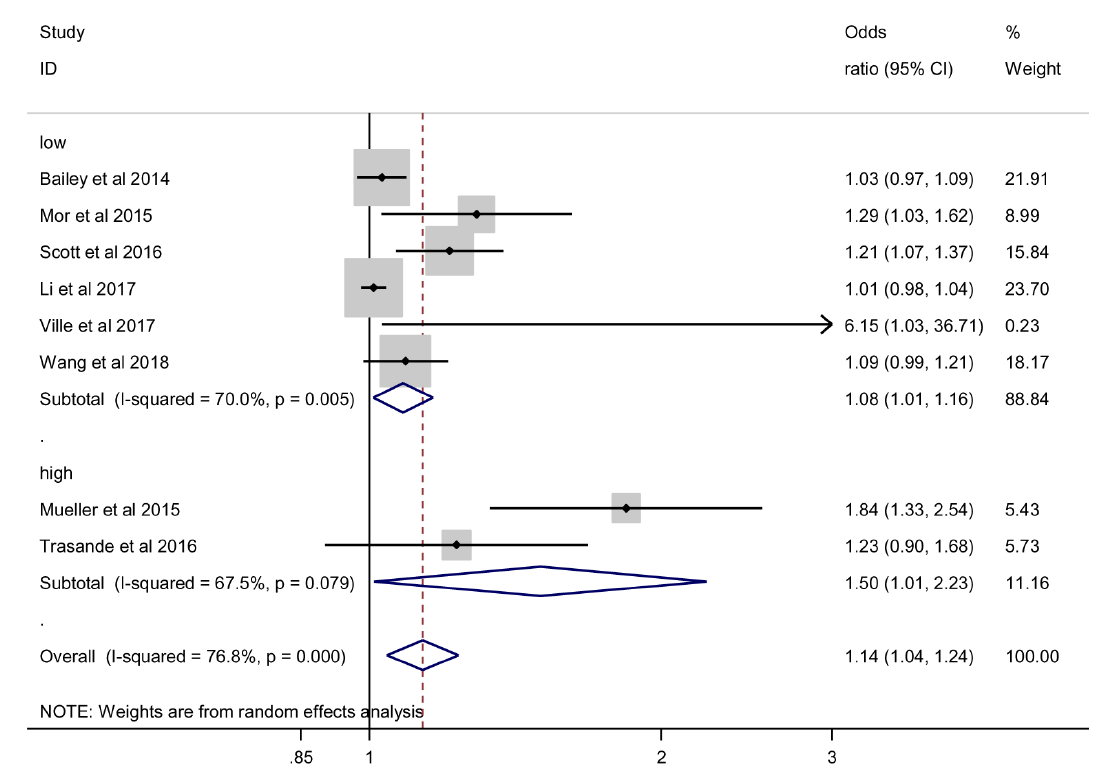
Figure 11. Obesity outcome, sensitivity analysis by risk of bias.